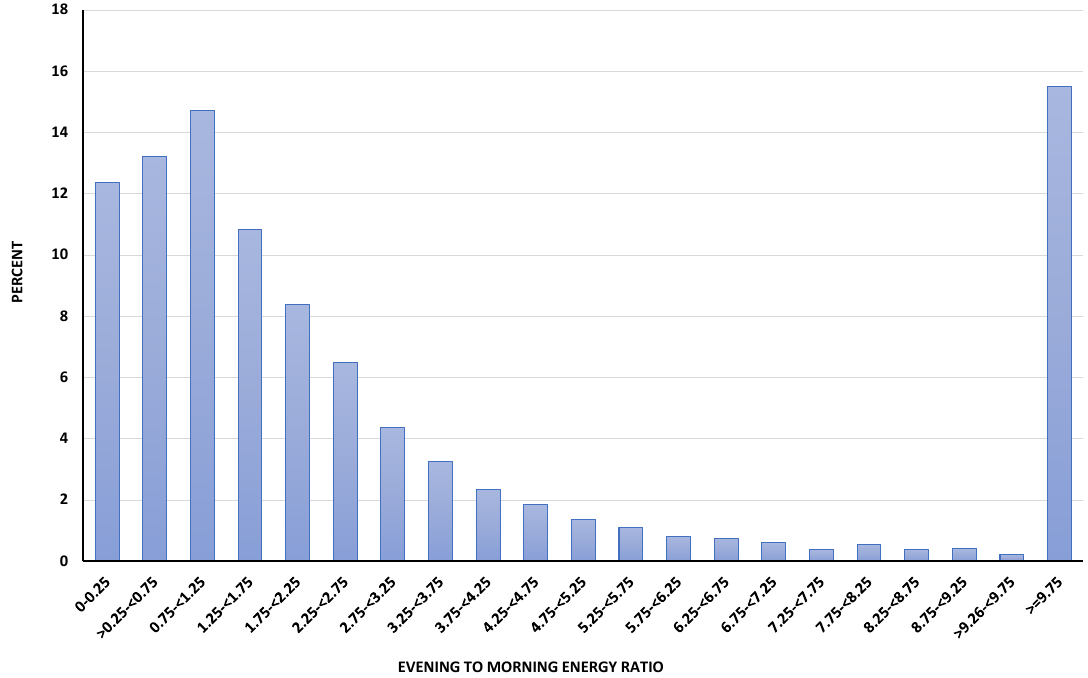
Figure 2. Histogram of evening to morning energy ratios. Evening / morning energy ratio was defined as energy intake between 6:00 and 11:55 p.m. (kcal) for evening intake divided by energy intake between 6:00 and 11:55 a.m. (kcal) for morning intake plus one according to Aljuraiban et al.’s definition [9]. Participants were categorized into four groups based on their evening / morning energy ratio using quartiles as cut-o ff points ( < 0.73; ≥ 0.73 to < 1.69; ≥ 1.69 to < 4.00; and ≥ 4.00). Individuals with lower values tended to consume more calories in the morning than evening, while individuals with higher values tended to consume more calories in the evening than morning (NHANES 2007–2016; n = 25,411; weighted N = 217,802,638).